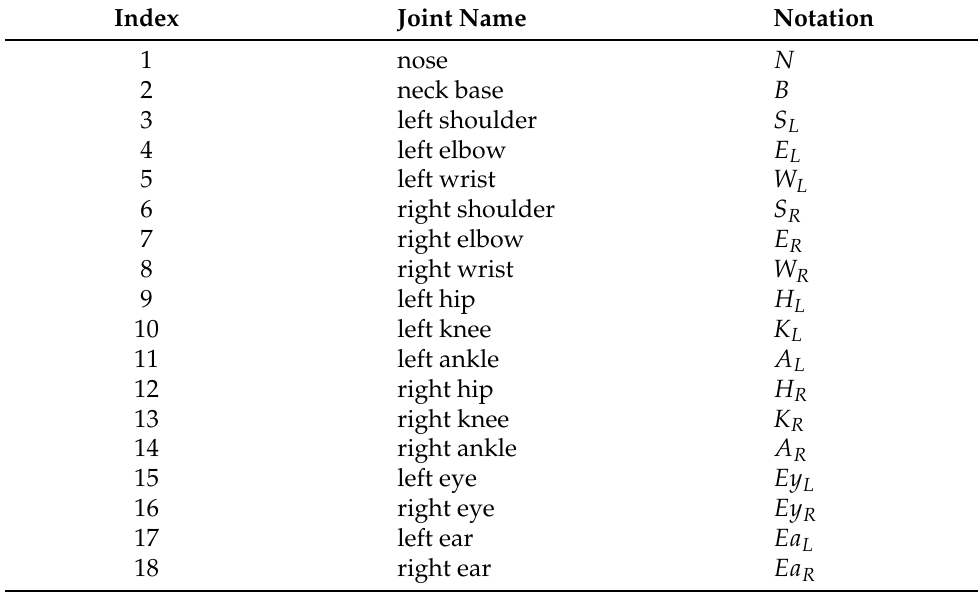
Table A1. Joint names.